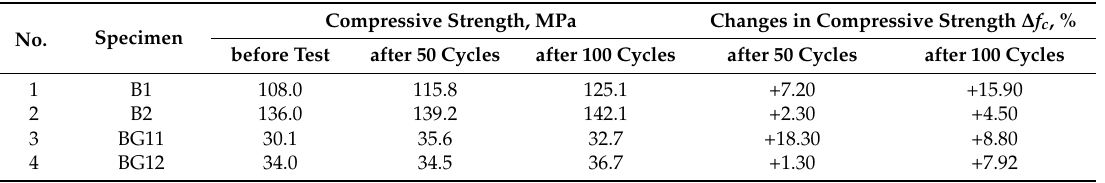
Table 4. Freeze–thaw test results of concretes with EGA and